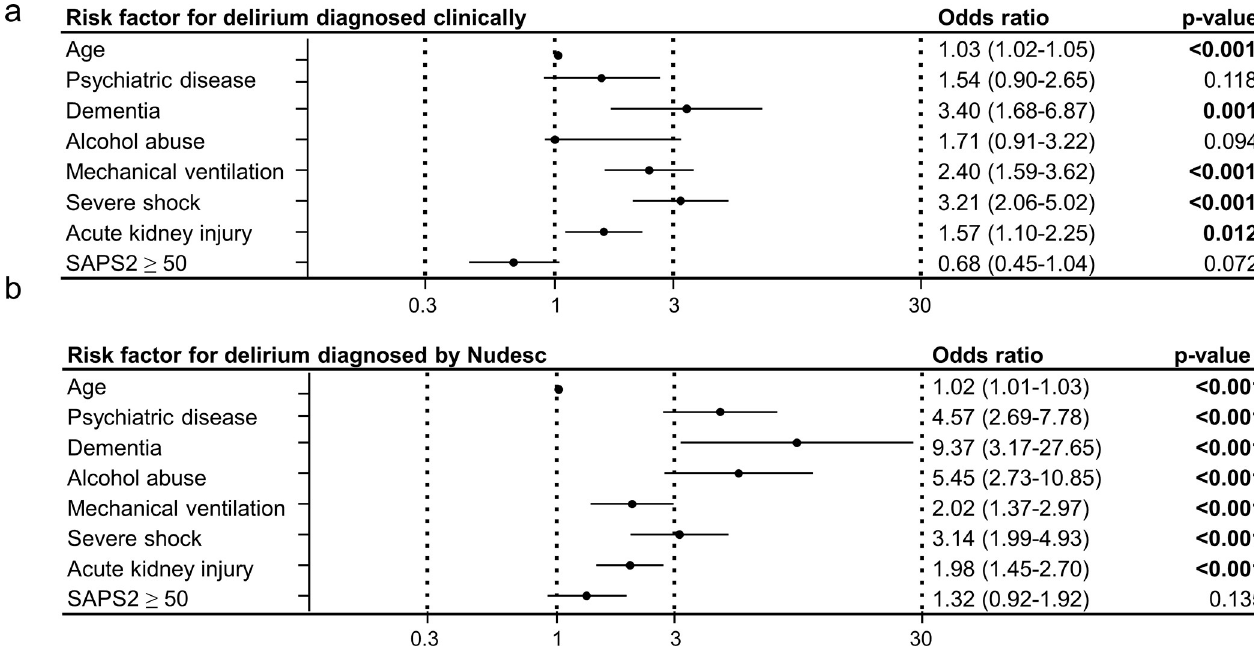
Fig 4. Risk factors for delirium. Figure shows multivariable logistic regression analysis with odds ratio (95% confidence interval) of different risk factors for delirium diagnosed by clinical diagnosis (a) and Nudesc (b). Odds ratios > 1 mark positive predictors, odds ratio < 1 negative predictors.